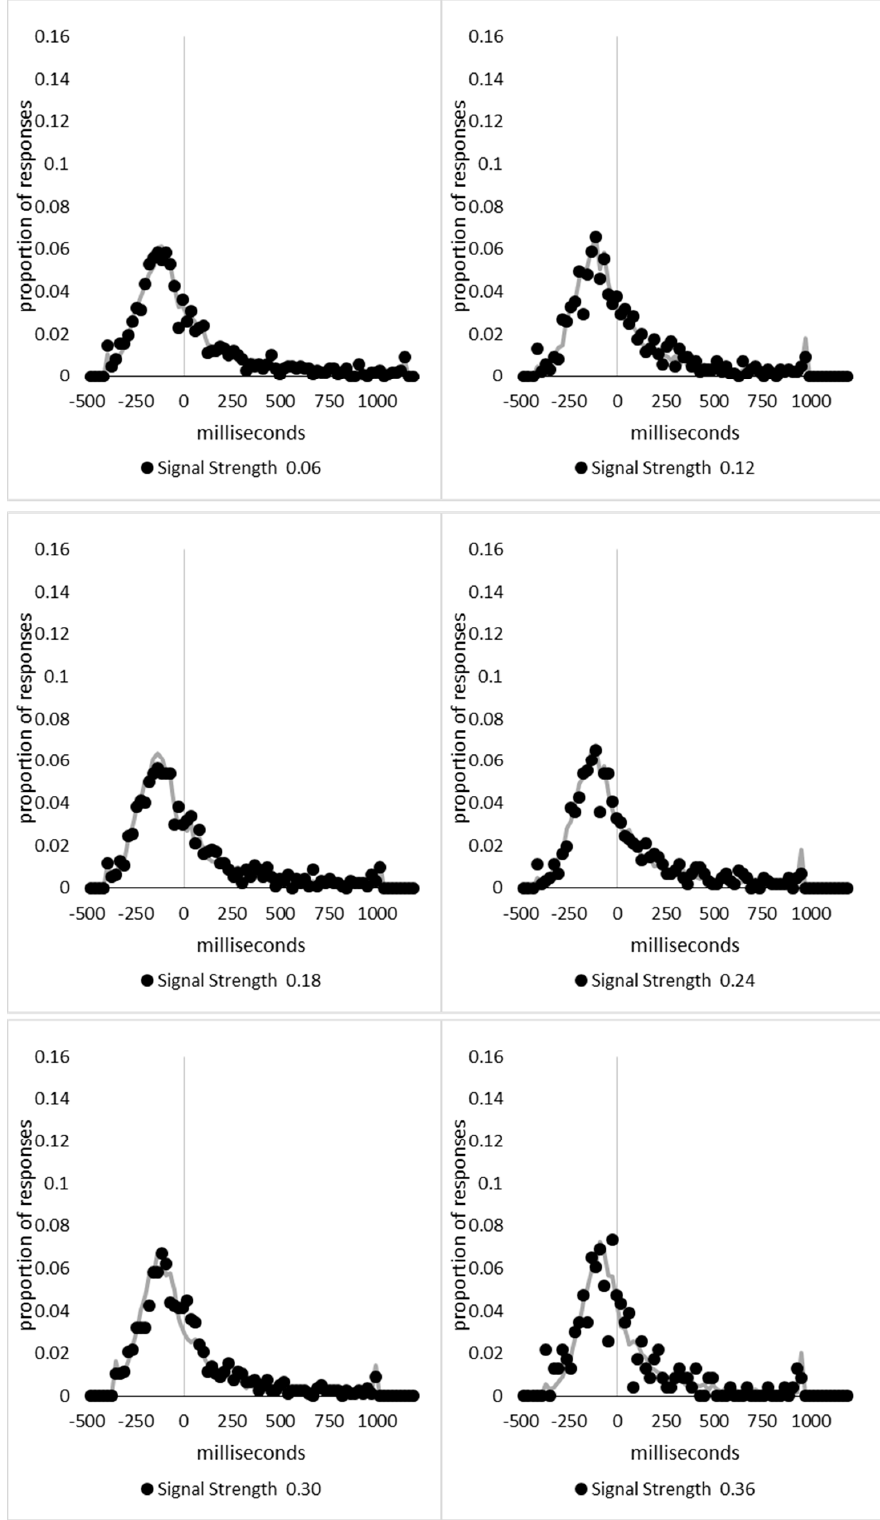
Figure A1. Density functions of the observed data (filled circles) and model (solid line) for signal strength bins 0.06 to 0.36.